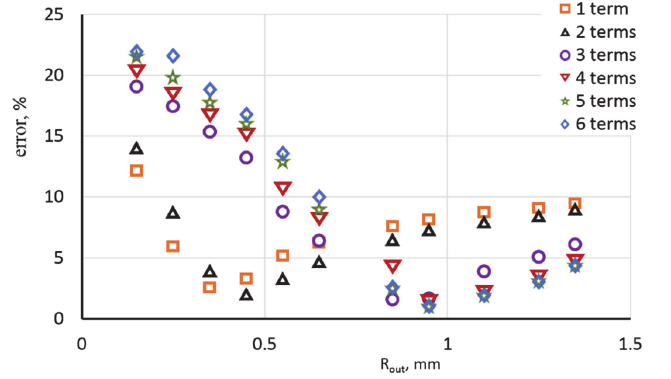
Figure 3: Effect of number of terms and size of the AOI (R out ) on the error in estimating the SIF.